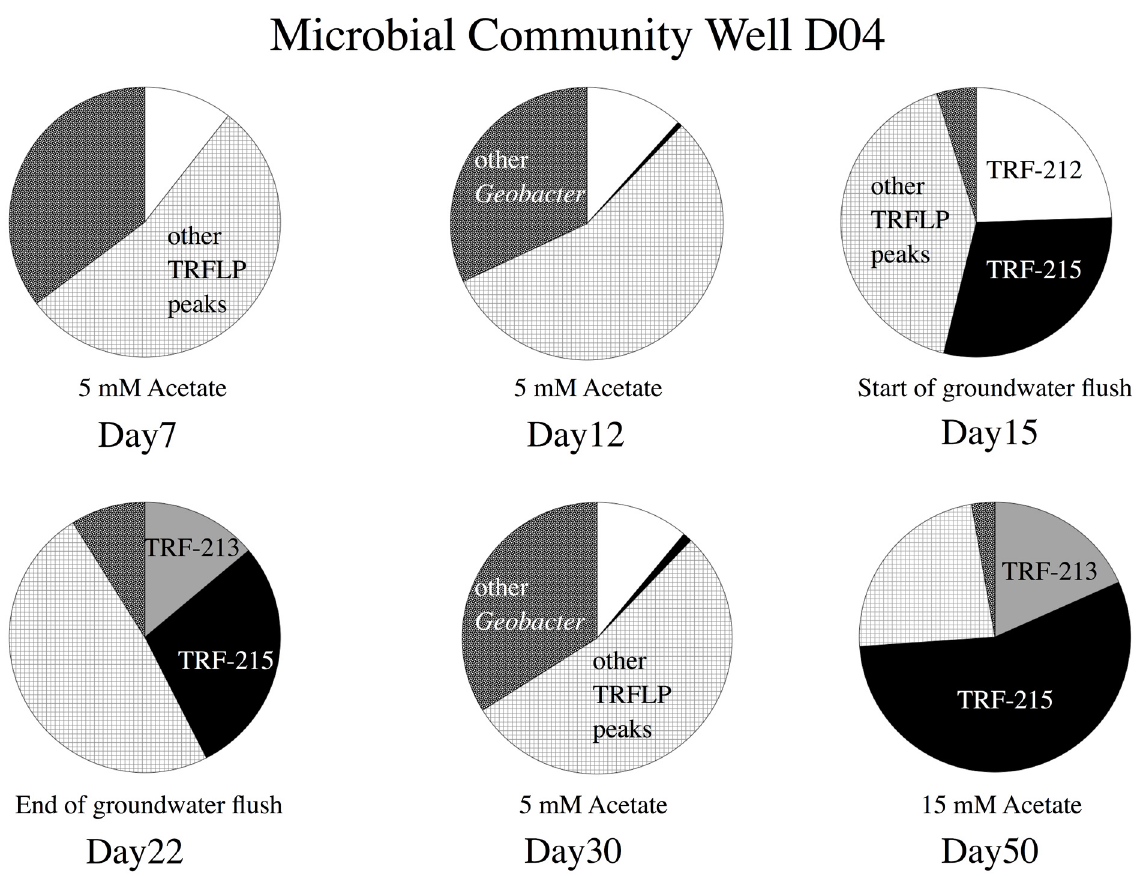
Fig 6. Percent total peak area from community DNA of 16S rRNA genes TRFLP profiles of pre-filters 2008 well D04 during field acetate injection: TRF 212-white, 213-light grey, 215-black, other Geobacter -like TRF ’ s-dark grey stipple, all other TRF peaks-light checked.